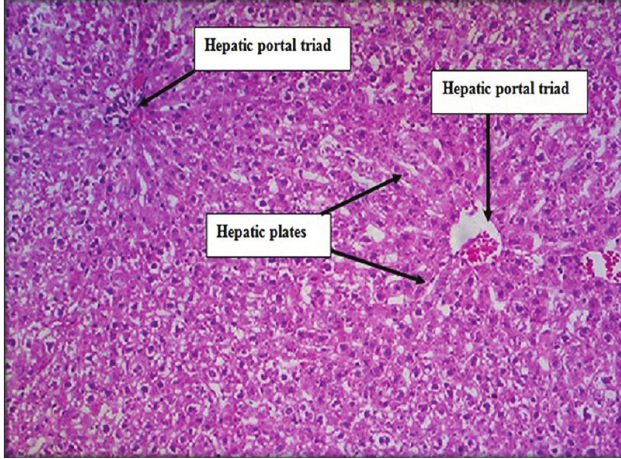
FIGURE 12 - Effect of risperidone on the liver of rats (H & E, 100x, 3 µ): Representative images of liver of rats treated with normal saline orally for three weeks showing no hepatic architectural